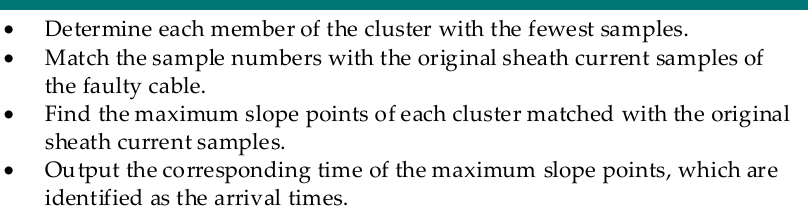
Figure 4. The process of identification of the arrival times at the two ends of the line.